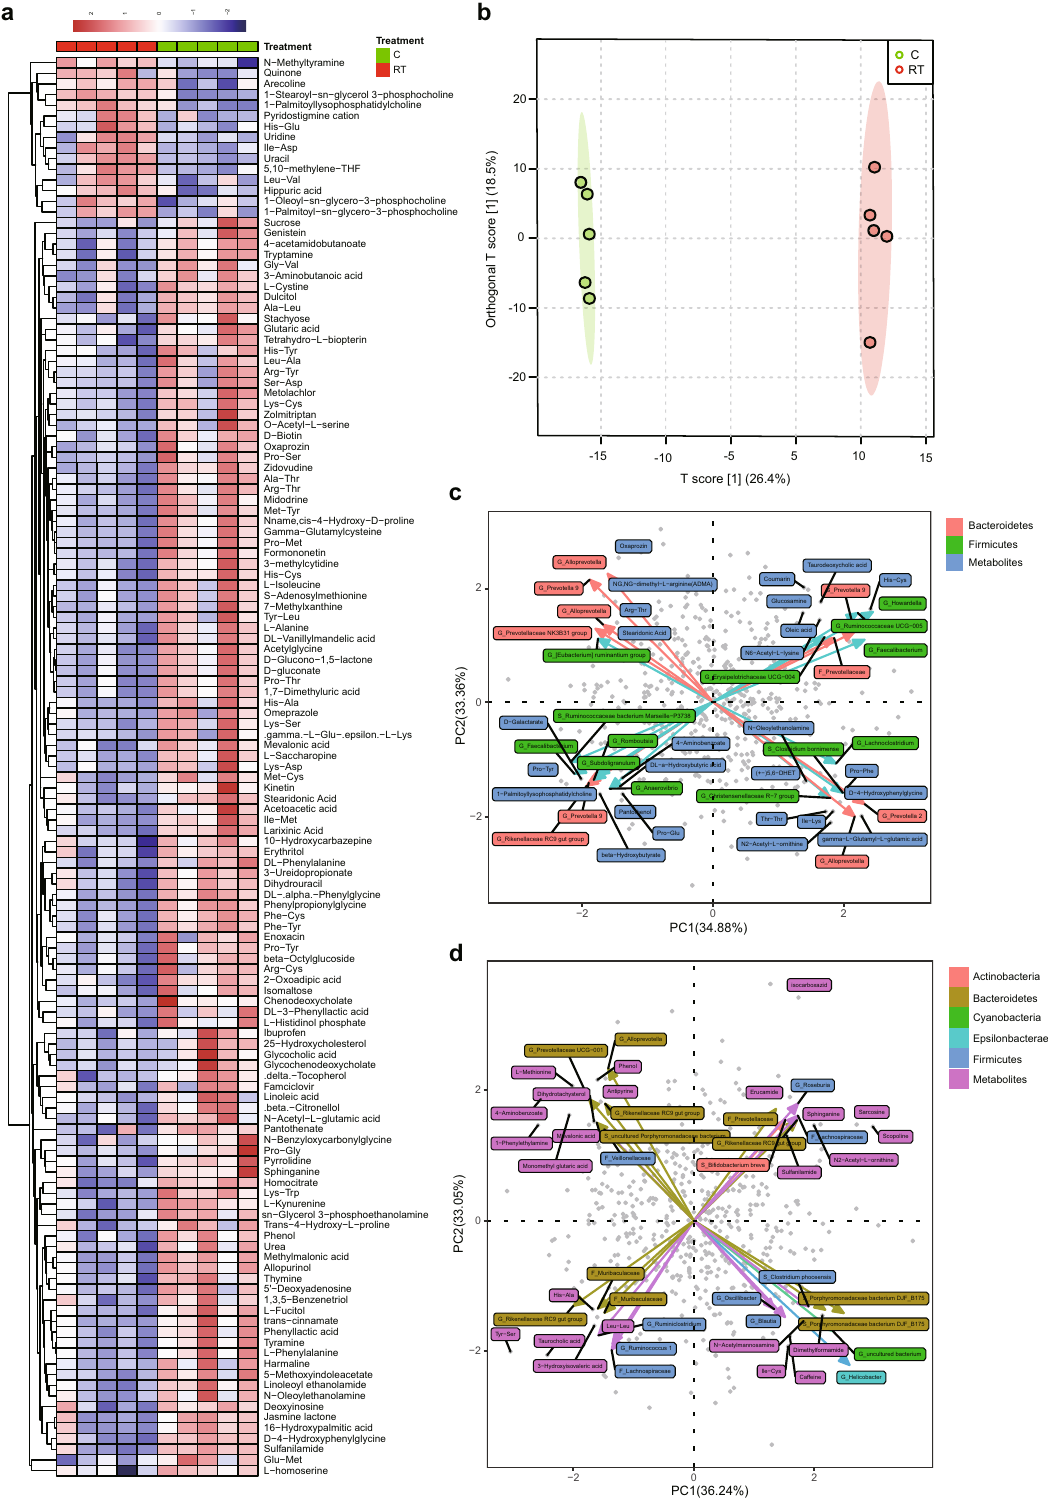
Fig. 5 Different metabolomic alterations in serum in the positive model and strong correlation with the microbiota of the contents and epithelial surface of the cecum. a Heatmap of differences in serum metabolites under cold stress. b Partial least-squares discriminant analysis (PLS-DA) of metabolites in serum. c Correlation of metabolite in serum with the microbiome of the cecal content. d Correlation of metabolites with the microbiota of the epithelial surface of the cecum. The data are the means ± SEMs ( n = 5 per